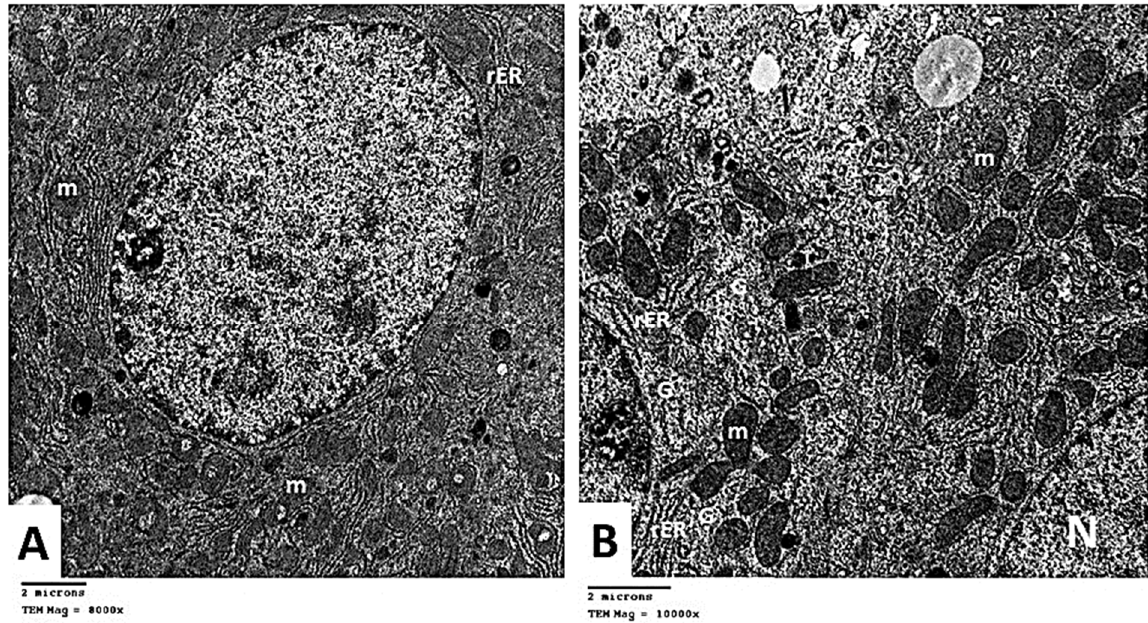
Figure 13. ( A ) Electron micrograph showing hepatocyte with nearly rounded nucleus (N) with mild irregularity in the nuclear membrane. Mitochondria (m) and rough endoplasmic reticulum (rER) are nearly similar to the control. Group III TEM × 8000. ( B ) Electron micrograph showing two hepatocytes. Part of the nucleus (N) is seen. Mitochondria of variable size and shape (m) are seen. An apparent increase in the rough endoplasmic reticulum (rER) and glycogen rosettes (G) is noticed compared to Group II. Group IV. TEM × 10,000.